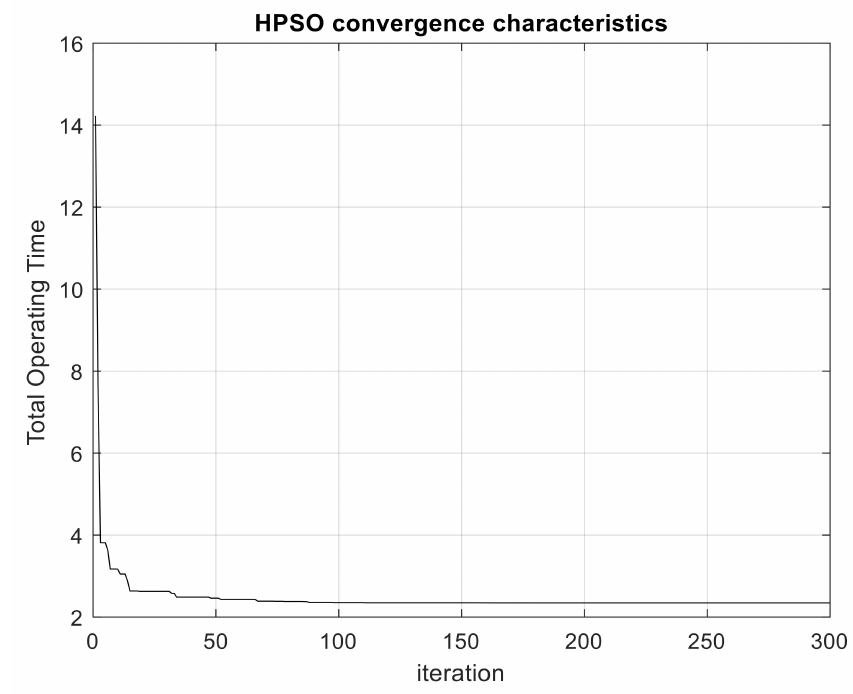
Figure 8. Convergence characteristic graph of OF (1) (Case 1).